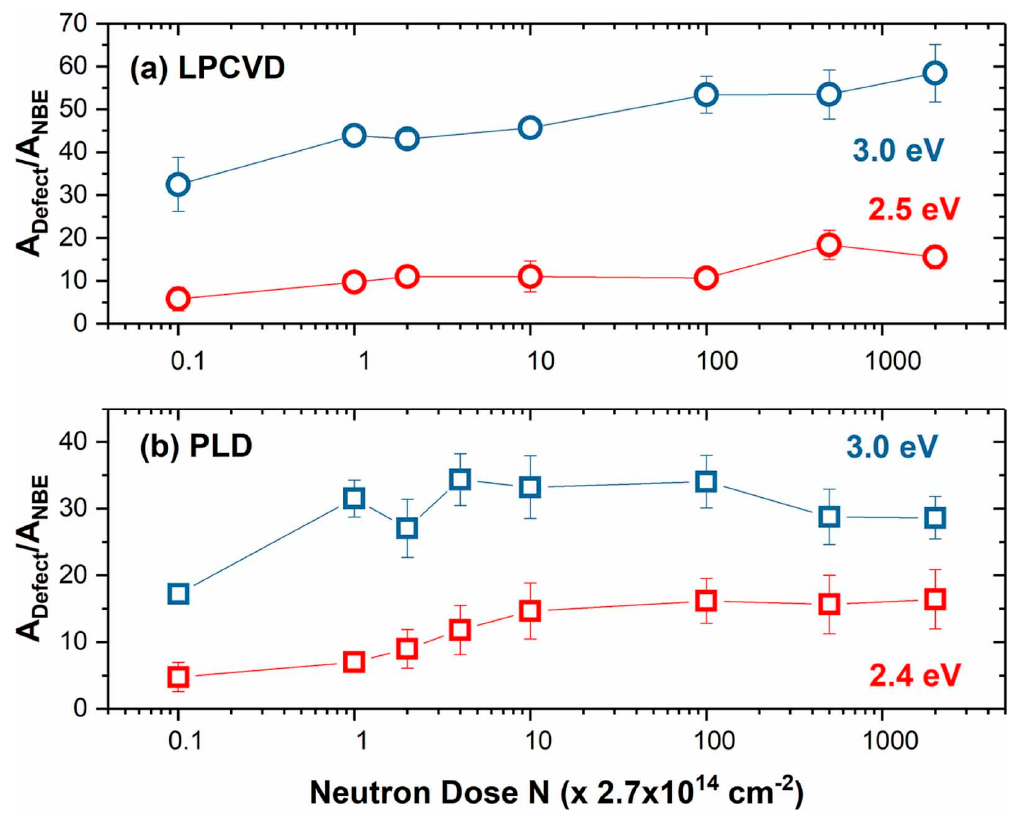
Figure 7. A Defect /A NBE vs. neutron dose for ( a ) LPCVD and ( b ) PLD. Reprinted/adapted with permission from Ref. [79], 2020, IOP Publishing Ltd.